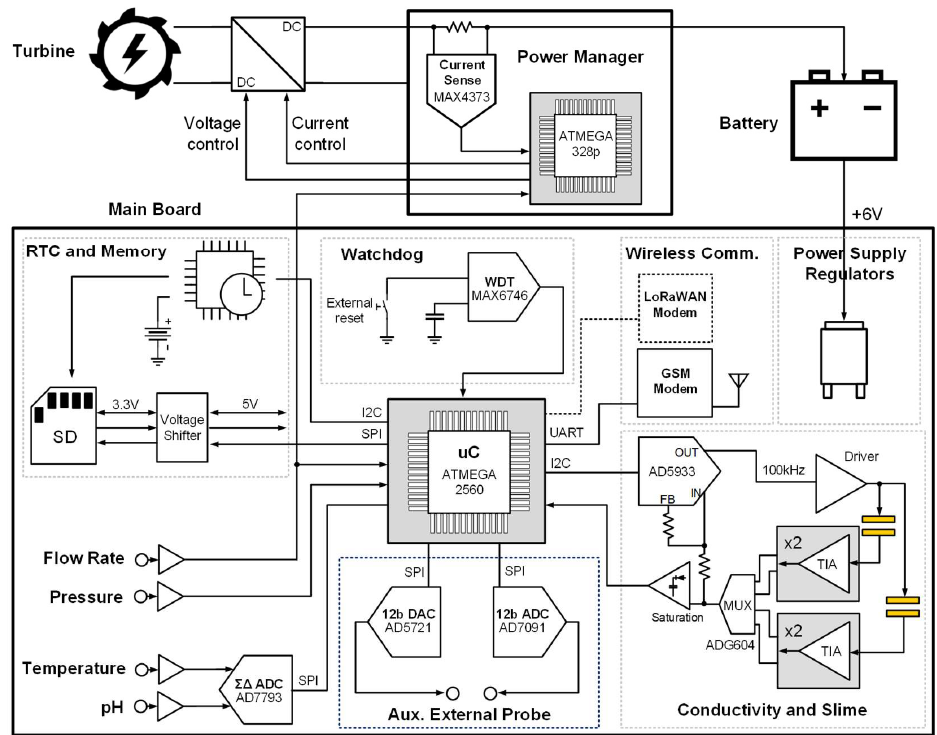
Figure 5. Scheme of the electronic platform, controlling the node: it is composed of the main board for conditioning, acquiring, and transmitting data and by a power management board for harvesting.